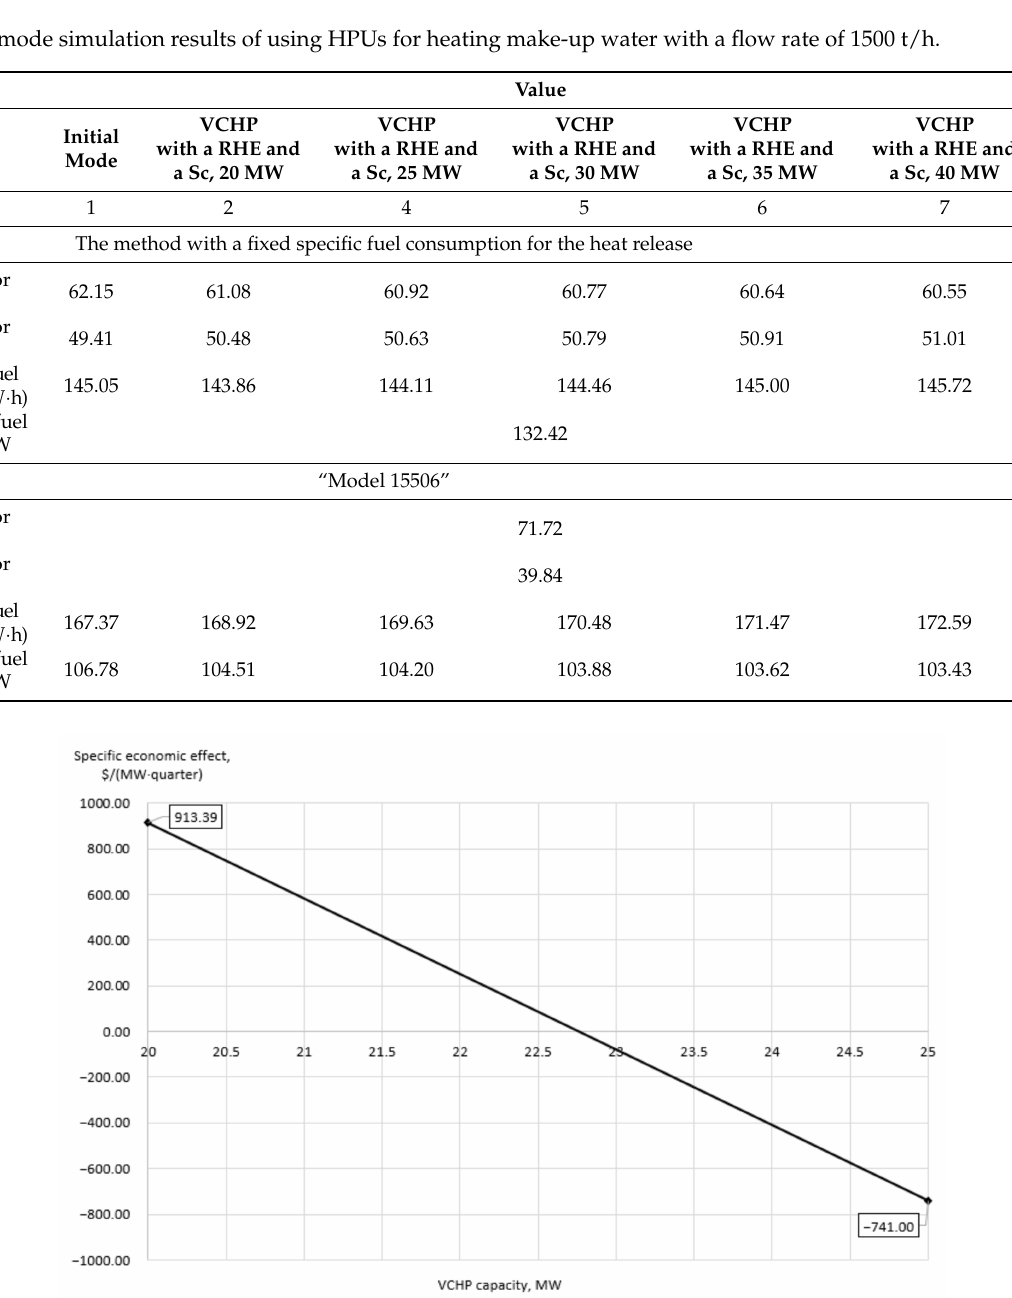
Figure 12. Influence of VCHP capacity on the economic effect of integrating VCHP for make-up water